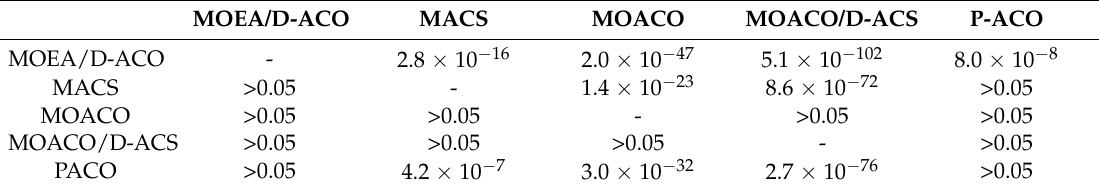
Table 9. Kruskal–Wallis test on euclidCE100 based on H-indicator.